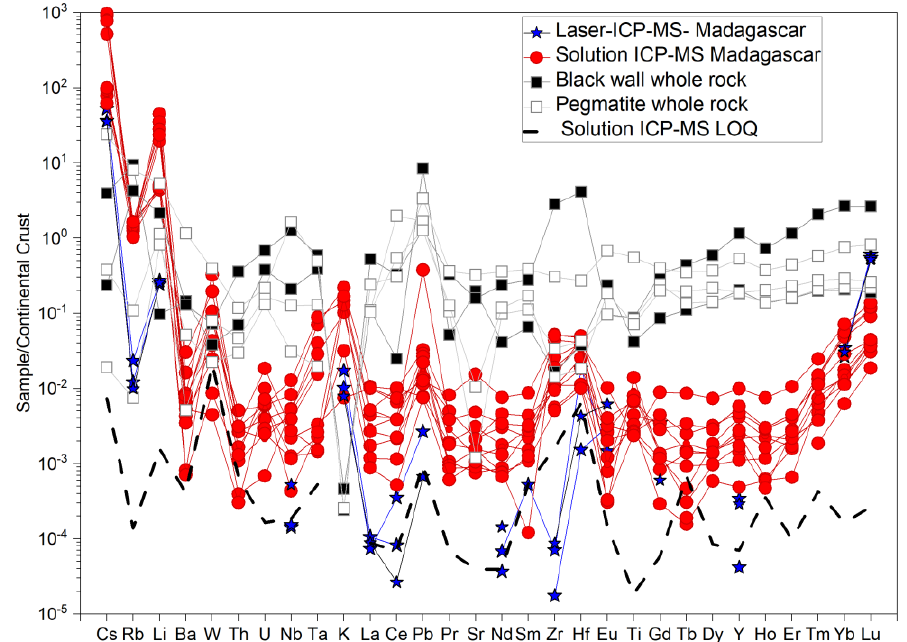
Figure 6. Incompatible trace element pattern for Malagasy emeralds measured by solution ICP-MS and laser ICP-MS; comparison with whole rock analysis of black wall and pegmatites from the same locality and LOQ shown. Elements are ordered by relative incompatibility and normalized to continental crust composition [28].